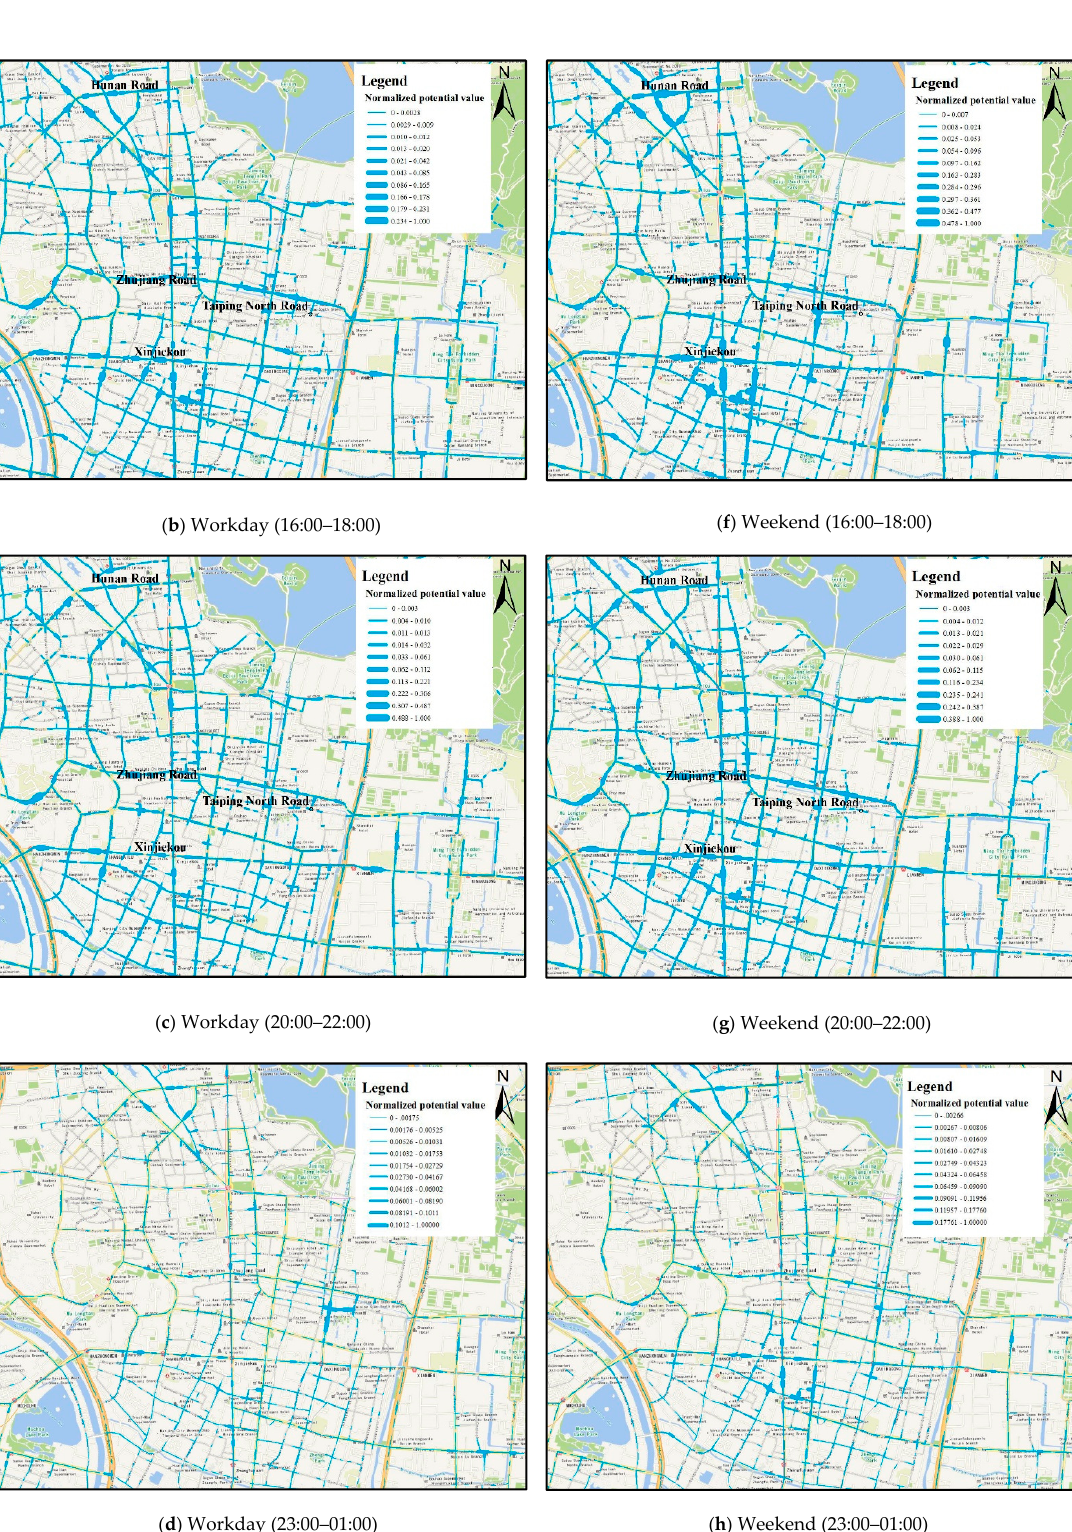
Figure 7. Spatiotemporal dynamic patterns of hotspots during di ff erent periods of the day and during the same time on di ff erent days: ( a – d ) workdays (8–9 September); ( e – h ) weekends (12–13